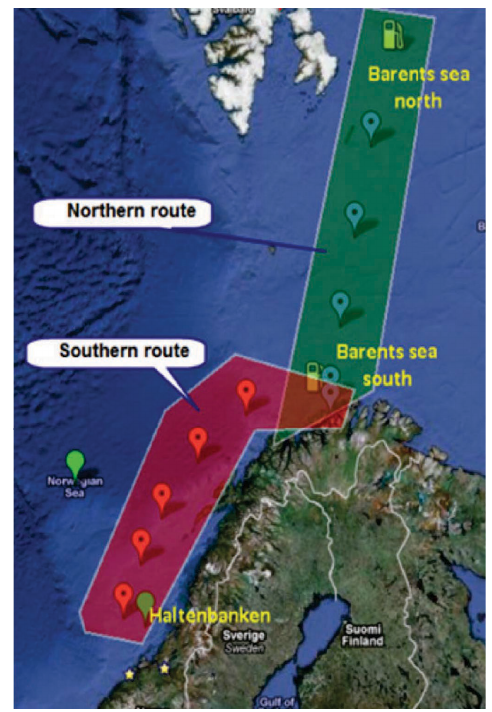
Figure 8: The CIV Arctic vessel was considered with a shore base at Hammerfest, and operations at Barents Sea North (Olga field), Barents Sea South (Goliat field), and Haltenbanken. Courtesy: Berg et al. (2011)